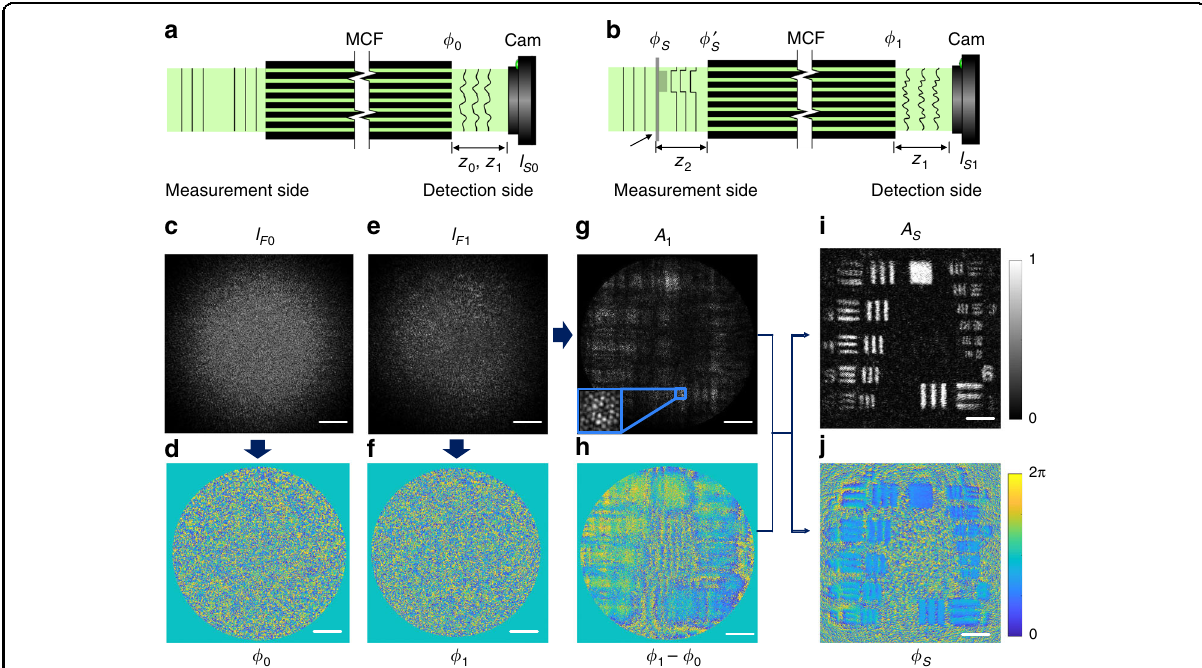
Fig. 2 Working principle of the lensless quantitative phase microendoscope. a The phase of a coherent light source is distorted by the MCF at the detection side. b A USAF resolution test target is located 1.6 mm away from the facet. The far- fi eld speckle image is captured on the camera. c Reference speckle image captured on the detection side with a point light source illumination on the measurement side. d Reconstructed reference phase image on the fi ber facet. e Far- fi eld speckle image of the test target. f Phase and g amplitude reconstruction on the fi ber facet, which contains the light fi eld information of the test target. h Retrieved phase image of the diffracted test target. Reconstructed i amplitude and j phase image of the 6th and 7th group elements of the test target on the focal plane. Scale bars 50 μ